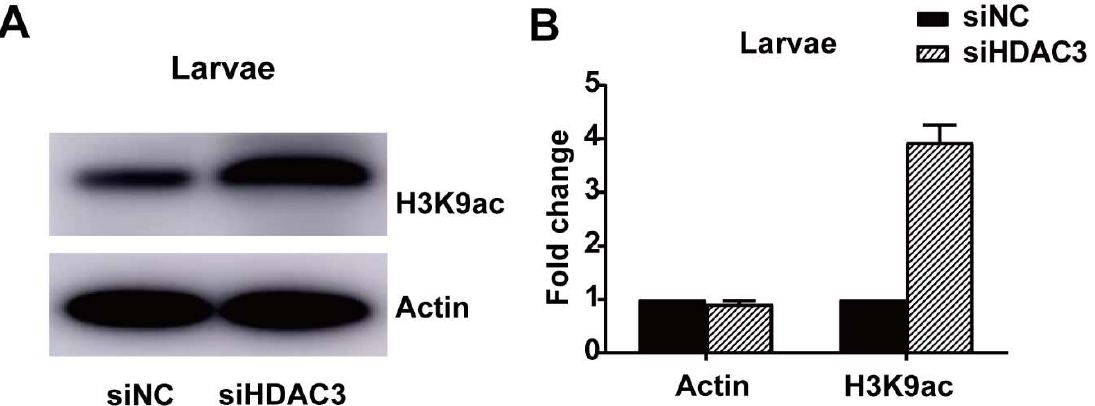
Figure 4. HDAC3 knockdown affects H3 histone acetylation in H. armigera . ( A ) Total protein content was extracted from siHDAC3 and siNC-injected larvae, separated on SDS-PAGE gels, subjected to immunoblotting, and hybridized with an acetyl histone H3-recognizing antibody. β -Actin protein served as a control. HRP-linked IgG was used as secondary antibody. Histone H3K9 lysine acetylation was elevated in HDAC3 -knockout larvae. ( B ) H3K9 levels were normalized against those of the loading control protein, β -actin. Band intensity was determined using